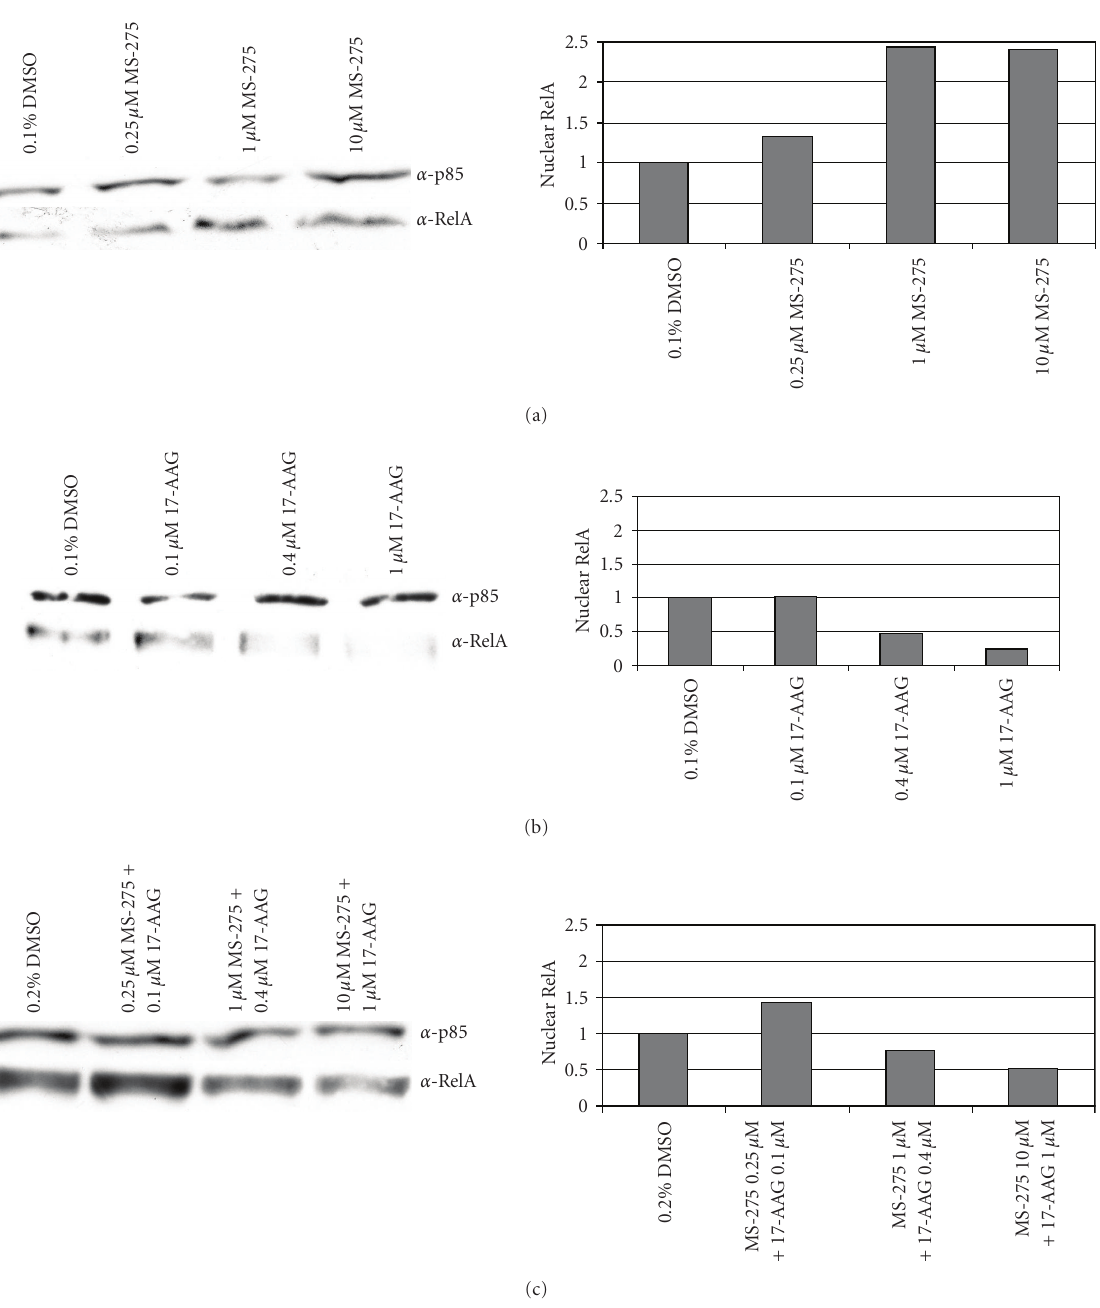
Figure 3: Dose Response of RelA . Immunoblots and quantitation of nuclear RelA after treatment with (a) MS-275, (b ) 17-AAG and (c) Combination. Following 24 hour treatment, nuclear and cytoplasmic extracts were prepared and quantified. 15 μ g were run on an SDS-page gel. Using immunoblotting techiniques, RelA and p85 (as a loading control) were detected using α -RelA and α -p85 antibodies. Protein levels following treatment are compared to vehicle control which is set at